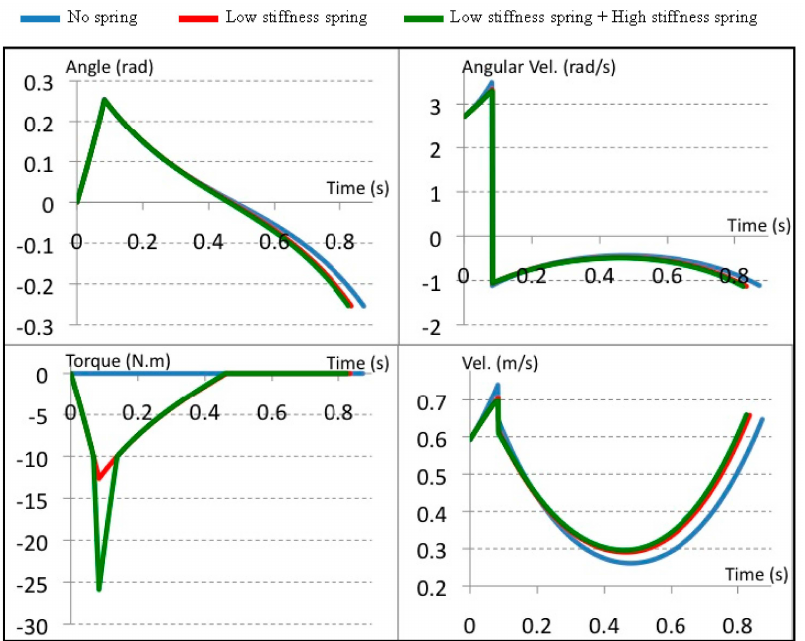
Figure 21. Simulation data for one-step walking in passive mode. The data is for 3 experimental mechanism sets. Low stiffness spring constant = 80 N/mm. High stiffness spring constant = 400 N/mm. ( a ) ankle pitch joint angle; ( b ) ankle pitch joint angular velocity; ( c ) ankle pitch joint torque; ( d ) CoM forward